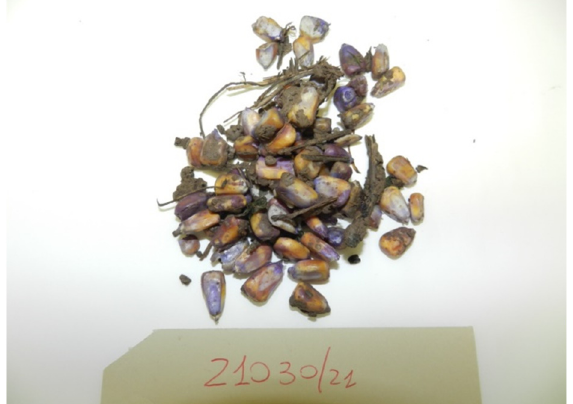
Figure 8. Violet corn.